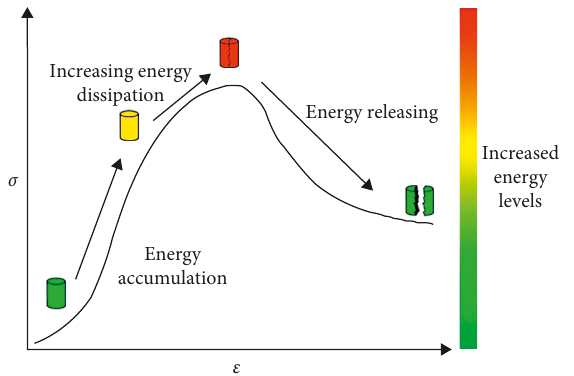
Figure 6: Evolution of containing energy